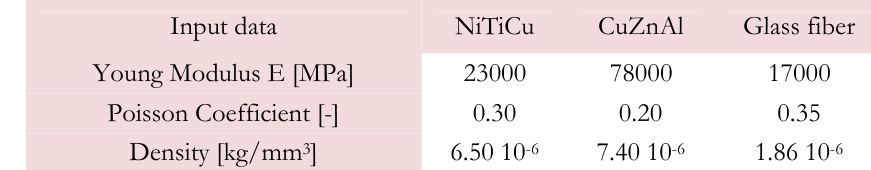
Table 2: Input data for the FEM analyses.